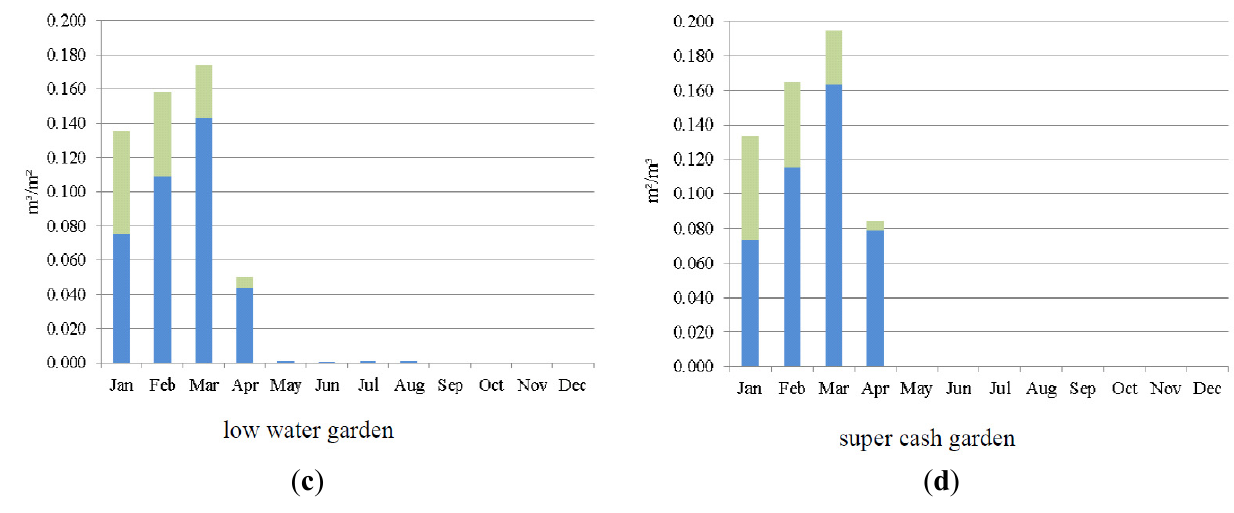
Figure 5. Crop water requirement (m 3 /m 2 ) with share covered by irrigation with harvested rainwater (blue) and precipitation (75% dependable rainfall) (green). Data base: [28,34]. ( a ) for subsistence garden; ( b ) for cash garden; ( c ) for low water garden; and ( d ) for super cash garden.